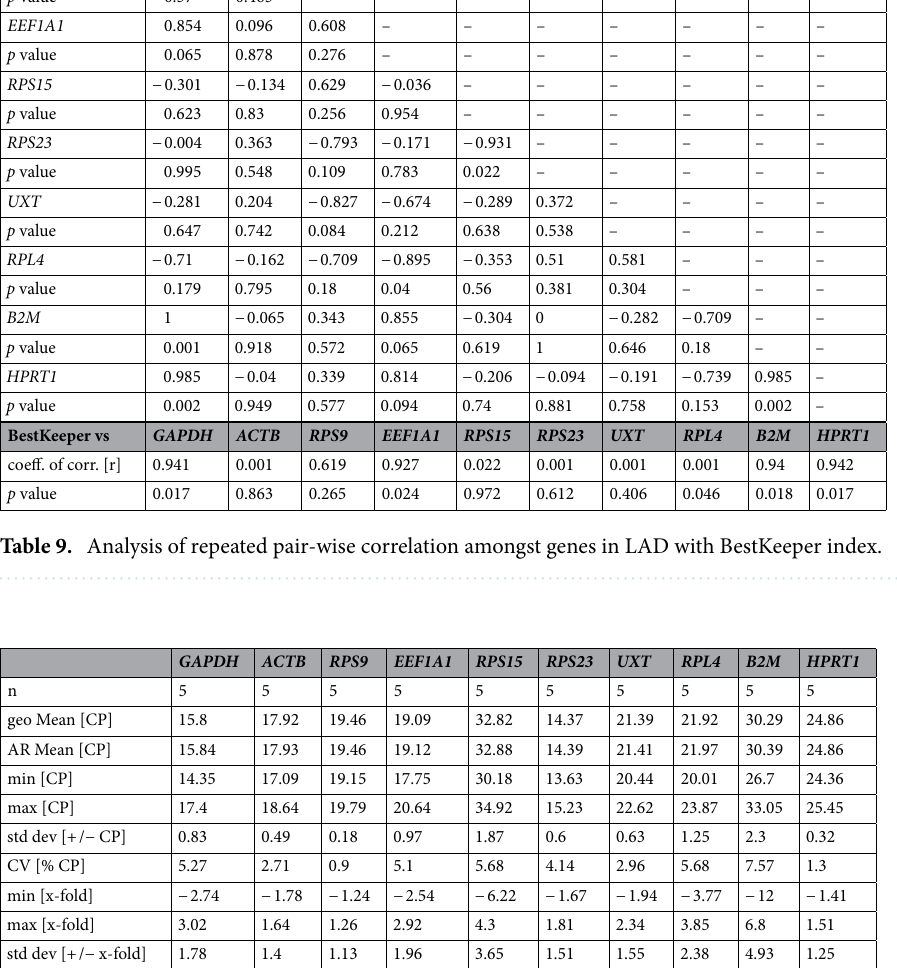
rRNA were most stable while ACTB was least reliable in PPRV infected PBMCs of goat. Similarly, identification of